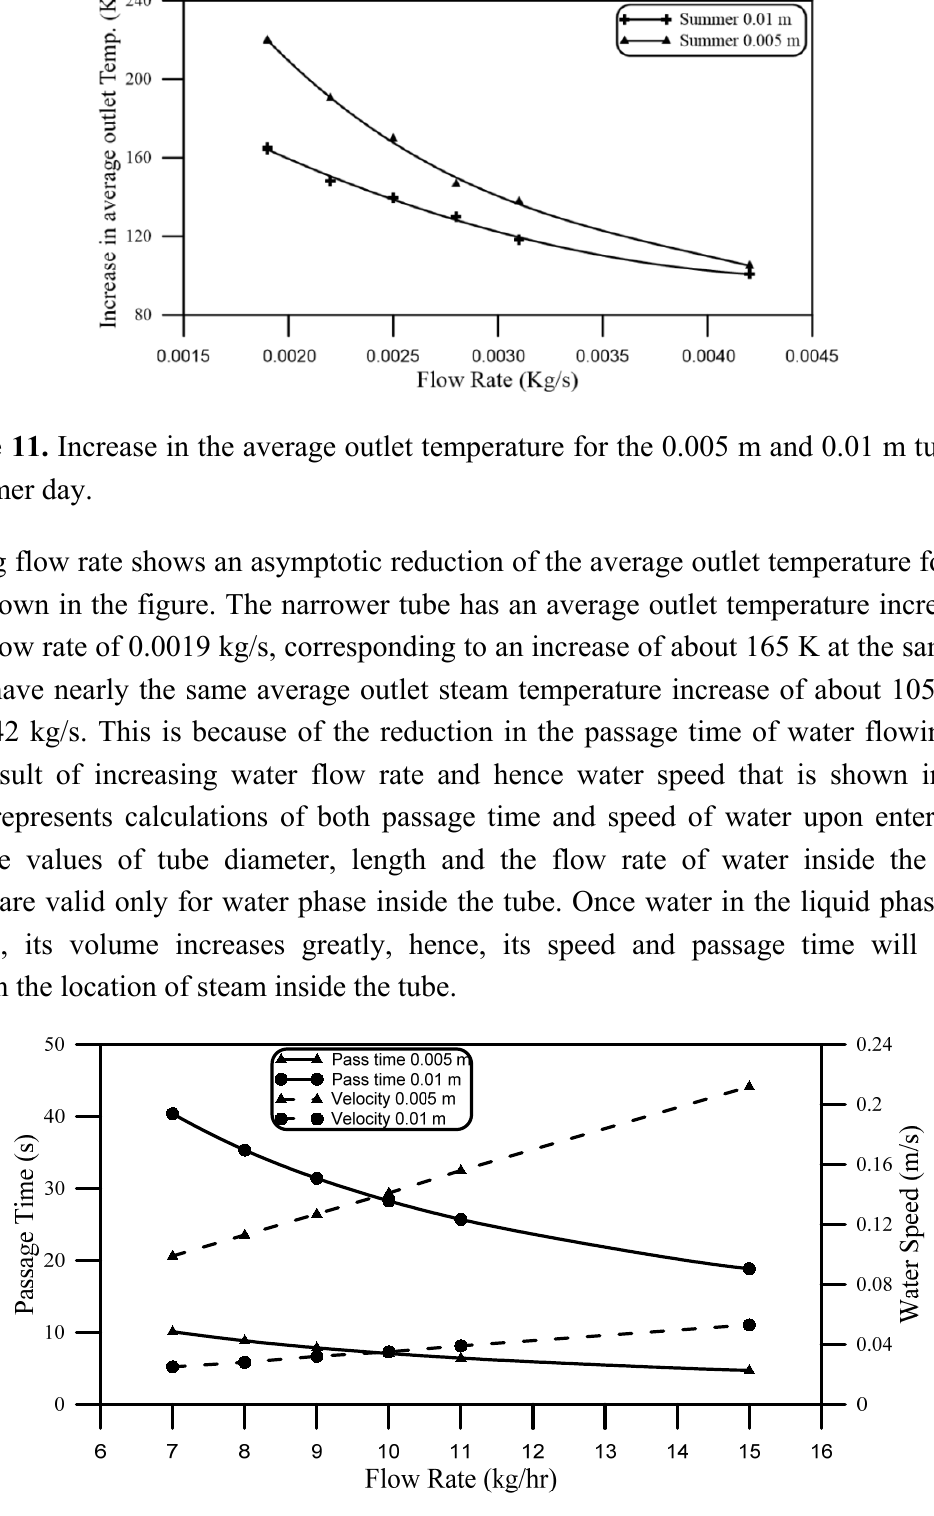
Figure 12. Passage time and velocity of water inside the 0.005 m and 0.01 m diameter